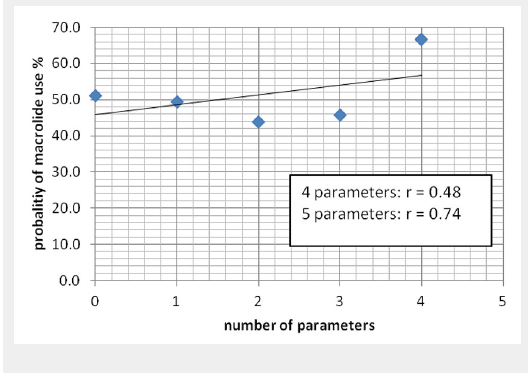
Correlation between the number of parameters investigated and the probability of macrolide use.